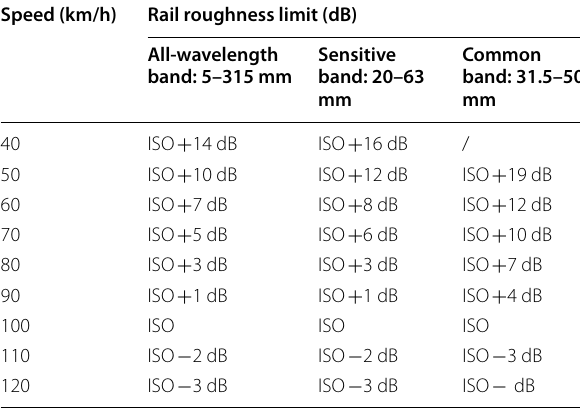
Table 2 Rail roughness limits at different speeds Speed